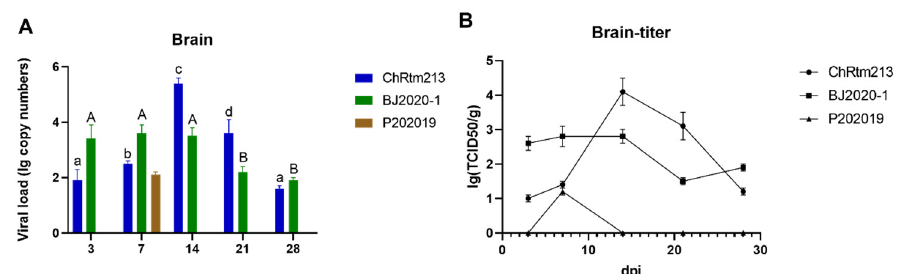
Figure 3. IPNV virus loads in the brain were sampled on 3, 7, 14, 21, and 28 dpi. ( A ) Replication kinetics of IPNV-infected rainbow trout. Samples were obtained in triplicate. Total RNA was extracted and analyzed by qPCR. Error bars represent the SD from triplicate within an experiment. Different letters of the same class indicated the statistical significance, p < 0.05. a, b, c, d indicated that the viral load of IPNV-ChRtm213 was significantly different at different sampling time points, p < 0.05. A, B indicated that the viral load of IPNV-BJ2020-1 was significantly different at different sampling time points, p < 0.05. ( B ) The detection of viral titers in the brain of IPNV-infected rainbow trout.